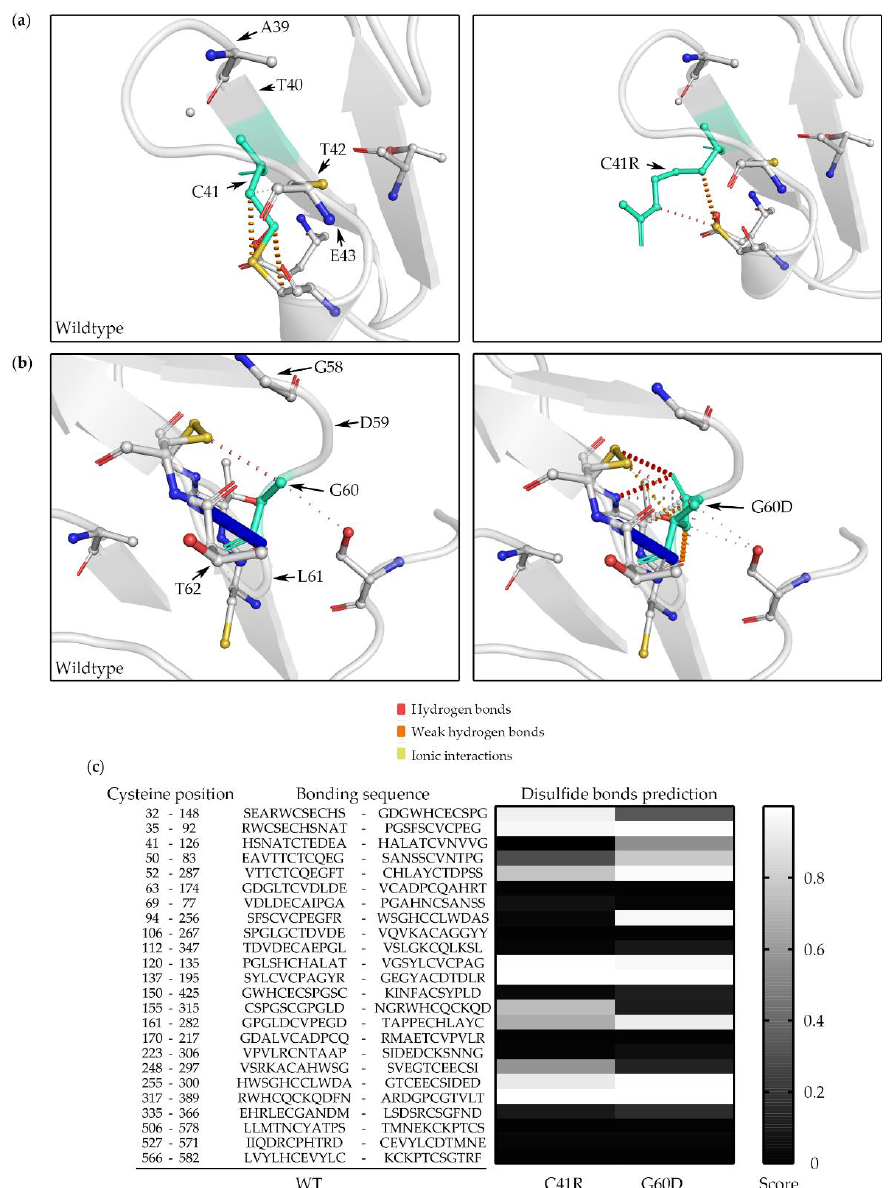
Figure 4. Uromodulin 3D structure and disulfide bond prediction. WT versus C41R ( a ) and WT versus G60D ( b ) were processed using DynaMut software. WT and mutant residues are colored in light green and are represented by sticks alongside the surrounding residues, which are involved in hydrogen bonds, weak hydrogen bonds, and ionic interactions. ( c ) Disulfide bond prediction of G60D and C41R uromodulin was analyzed using DiANNA software. The 24 disulfide bond positions and sequences of WT uromodulin are listed, and the prediction model shows that multiple disulfide bonds might be affected by C41R and G60D variants. WT: wildtype; G60D: p.Gly60Asp; C41R: p.Cys41Arg.